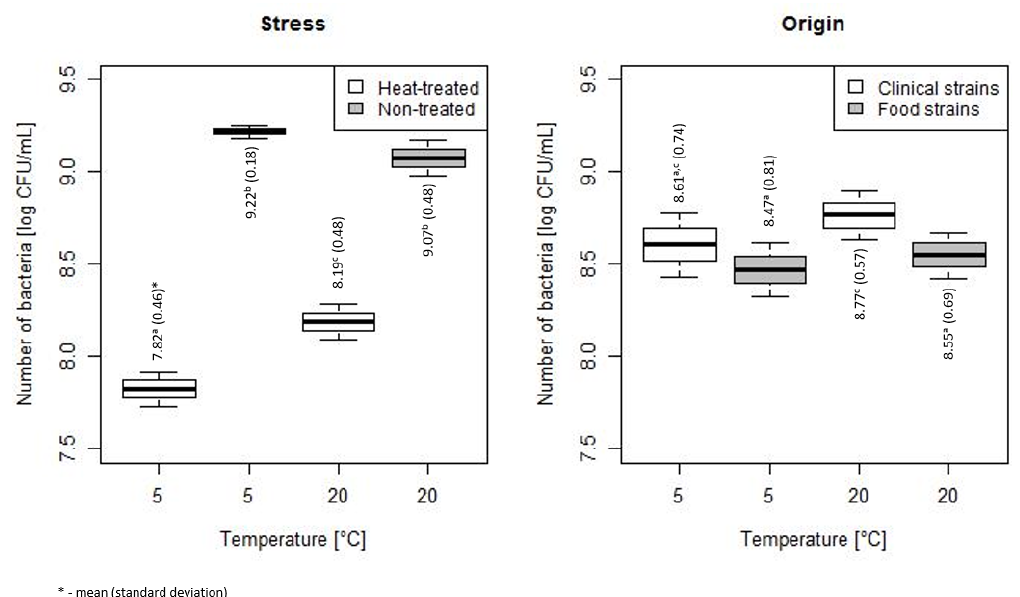
Figure 2. Comparison of bacterial counts of heat-treated (HT) and non-treated (NT) bacteria, and for clinical and food strains (the horizontal line is the mean, the box spans represent standard error and the whiskers represent 95% confidence interval).